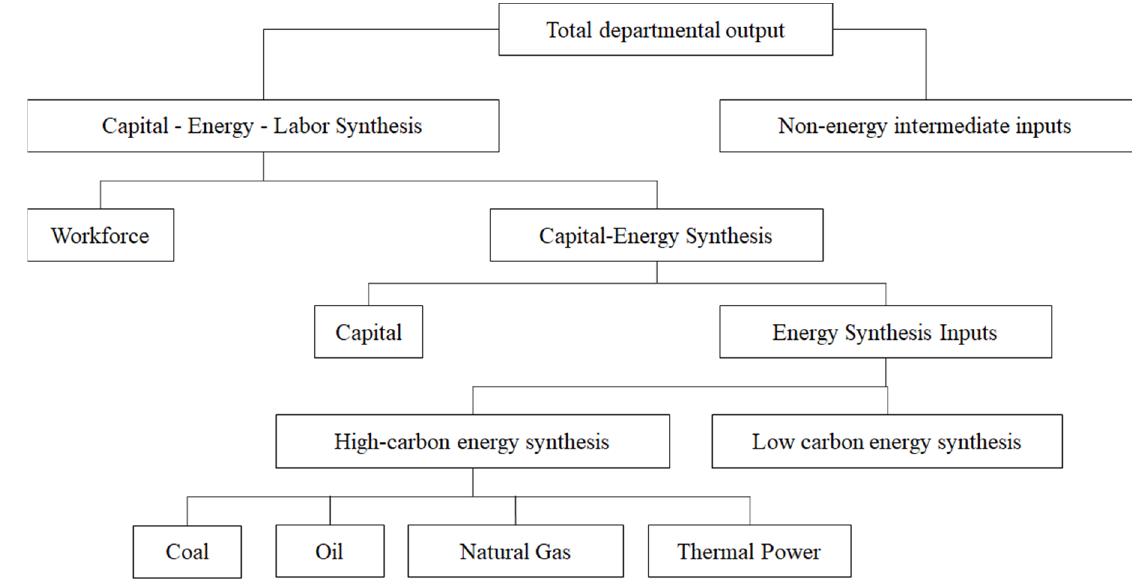
Figure 3. Schematic diagram of the structure of the production function.